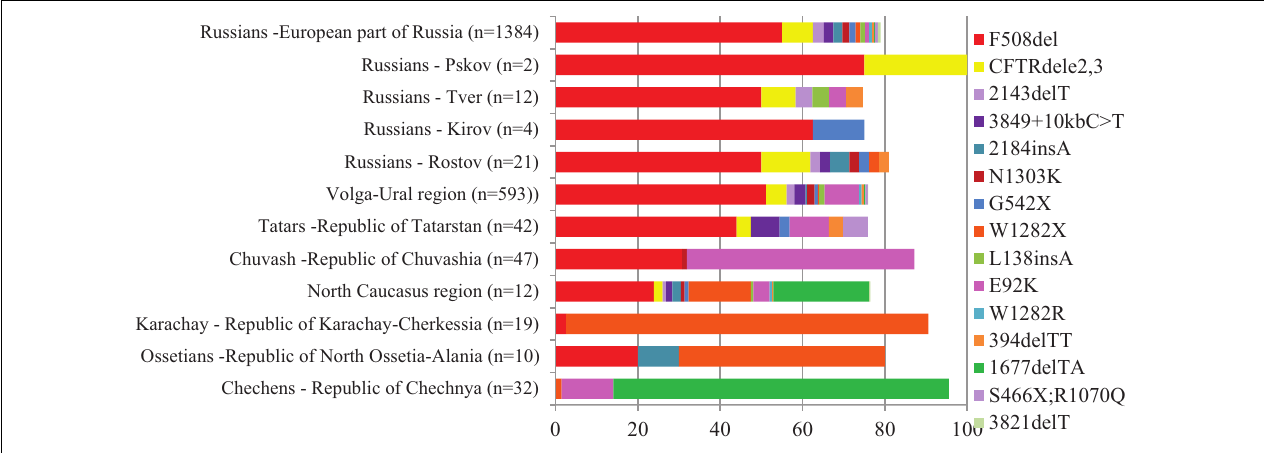
FIGURE 1 | Relative frequencies of common CFTR variants in studied regions and ethnic groups of European part and North Caucasus of